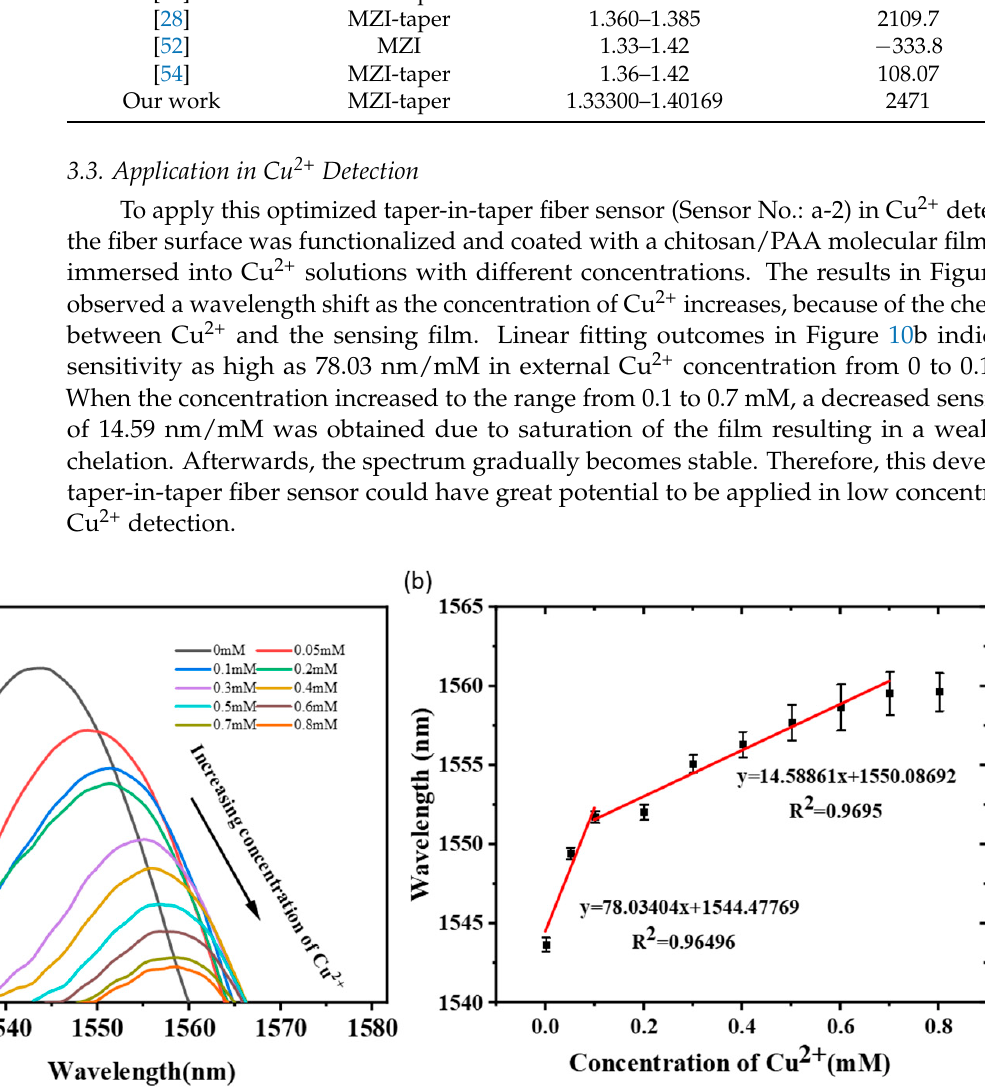
Figure 10. Detection results in various Cu 2+ concentrations: ( a ) Wavelength shift and ( b ) its linear fitting result.